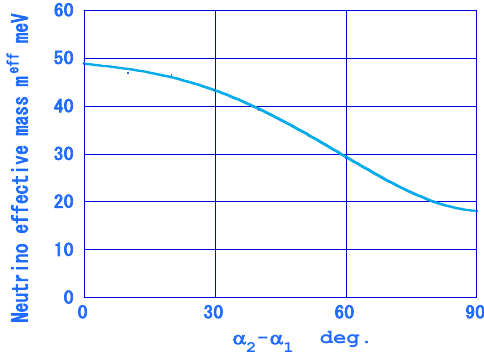
Figure 3. Effective neutrino masses m ef f in the case of IH as a function of the phase difference α 2 − α 1